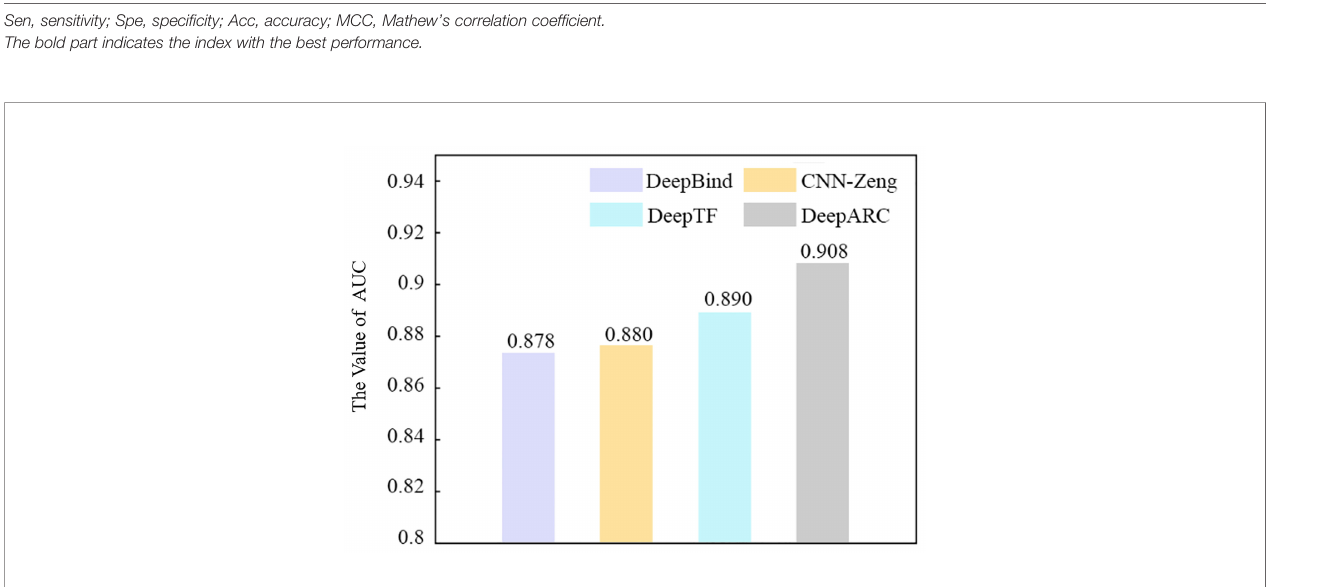
FIGURE 3 | Performance of DeepARC and three existing predictors in ROC-AUC. ROC, receiver operating characteristic; AUC, area under the ROC curve.